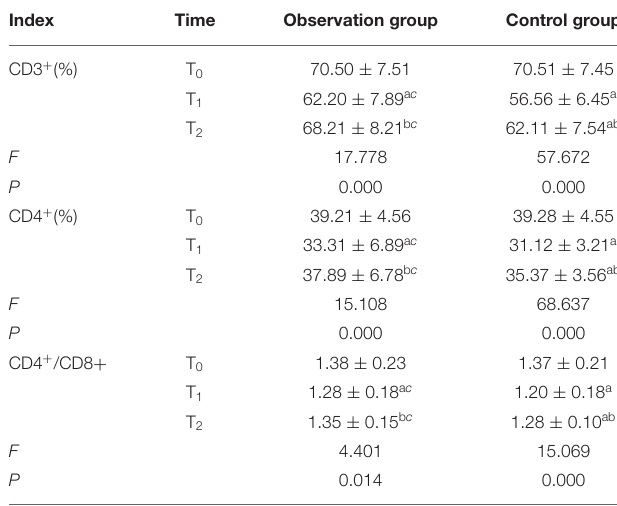
TABLE 4 | Immune function indicators of patients ( x ± s).